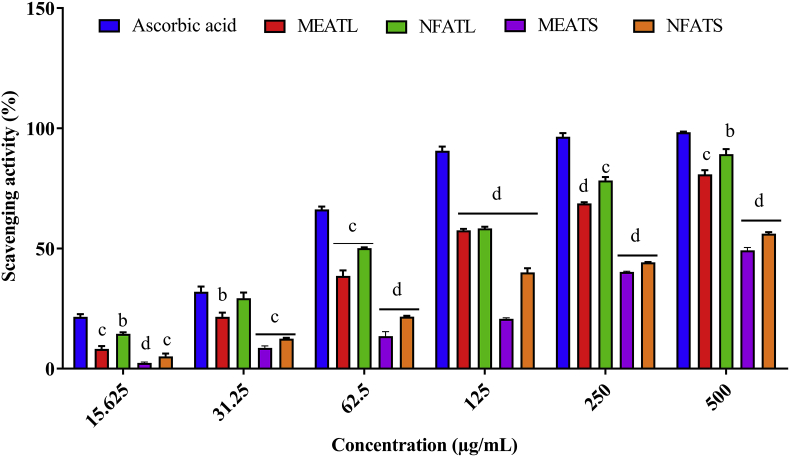
Percentage of radical scavenging activities the DPPH assay of A. trilobata fractions and standard drug at different concentrations. Values are represented in Mean ± SEM (n = 3). b P < 0.01, c P < 0.001 and d P < 0.0001 are statistically significant in comparison to ascorbic acid followed by unpaired t-test of one-way ANOVA (GraphPad Prism 7). MEATL: Methanolic extract of A. trilobata leaves, NFATL: n-hexane fraction of A. trilobata leaves, MEATS: Methanolic extract of A. trilobata stem and NFATS: n-hexane fraction of A. trilobata stem.